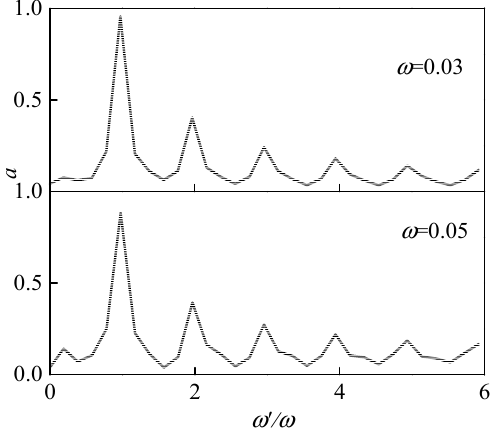
Figure 15. Spectra of wave run-up on a vertical seawall for multi-crest wave train cases of different wave frequencies.